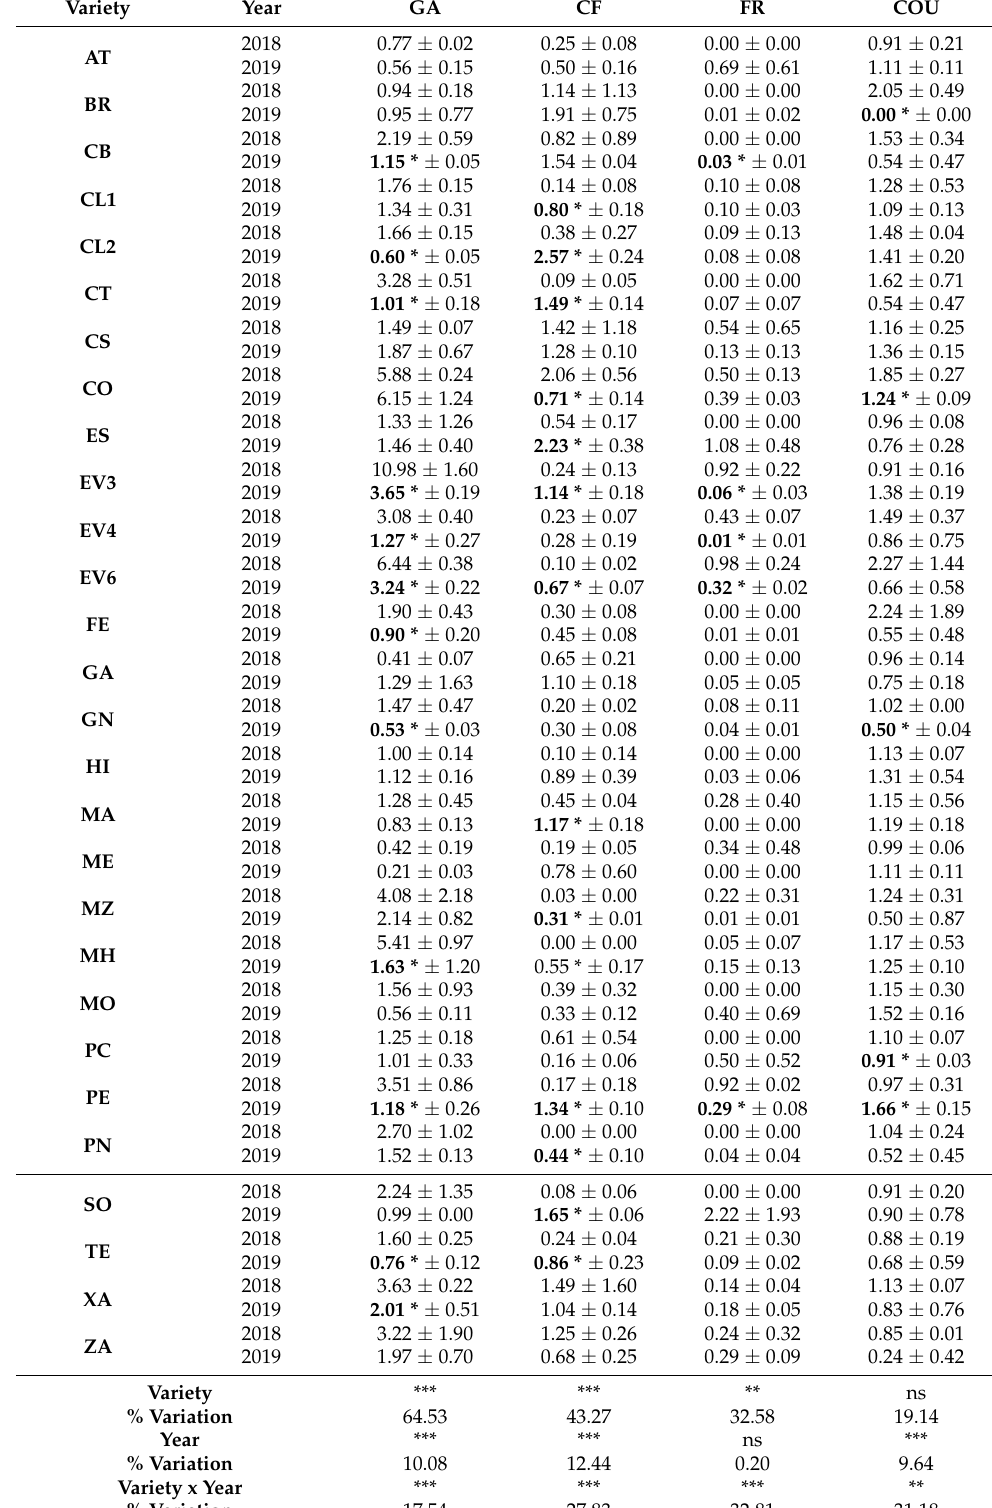
Table 5. Concentration of hydroxybenzoic and hydroxycinnamic acids from the EVEGA germplasm bank in 2018 and 2019 vintages. (Values are expressed as mg · kg − 1